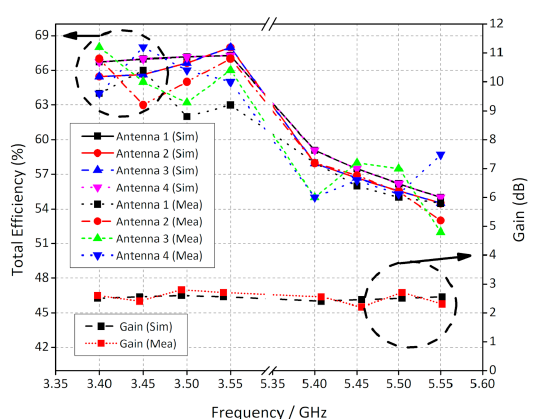
Figure 8. Performance parameters of proposed Dual band MIMO